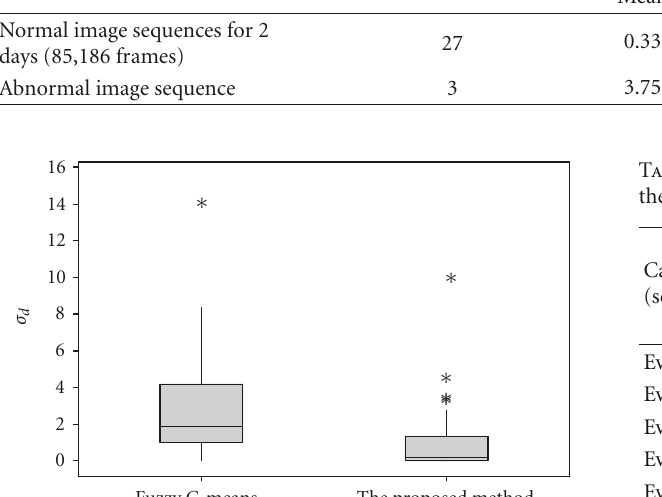
Table 2: Statistical analysis for the two-day normal video sequence of the laboratory scene and the three abnormal events. Image sequence